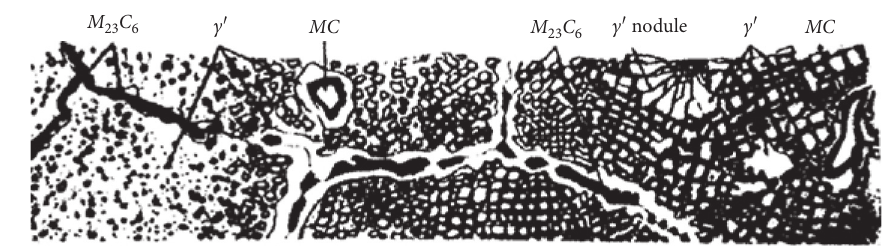
Figure 2: Grain structure of nickel-based materials [11].